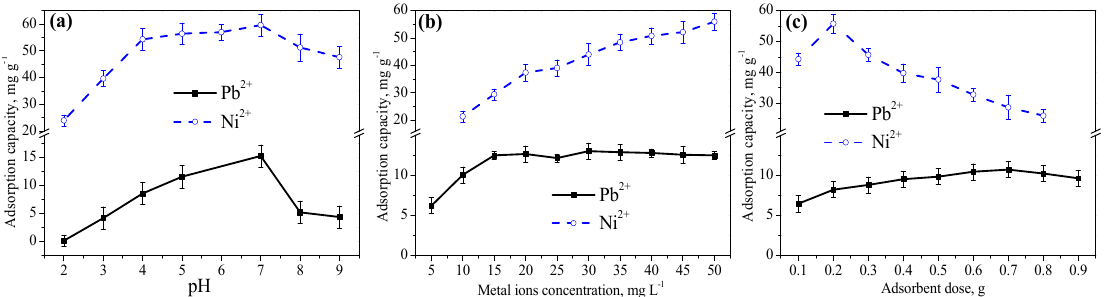
Figure 5. The adsorption capacity of Pb 2+ and Ni 2+ vs. ( a ) solution pH, ( b ) initial metal’s concentration, and ( c ) dose of PANmod.